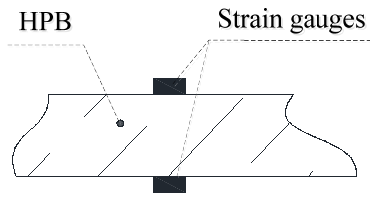
Figure 1. Pair of opposed dual-gauges.